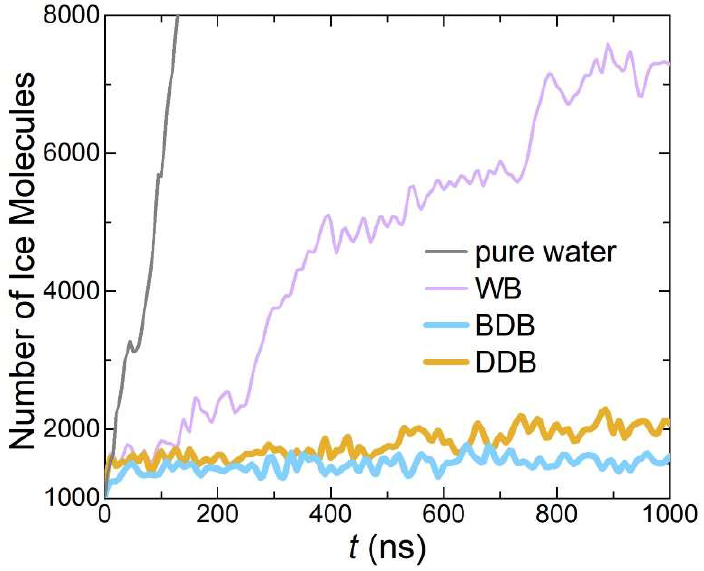
Figure 2. AFGP8 inhibits ice growth. The growth of ice on prism surface at 268 K in pure water (gray line) and AFGP8 solutions. Three binding cases of AFGP8: weak binding (purple line), backbone dominant binding (cyan line) and disaccharide dominant binding (orange line).